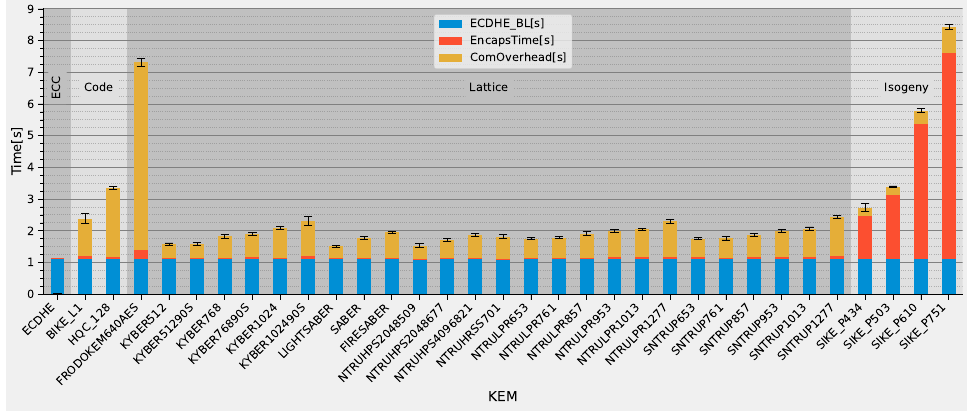
Figure 7. TLS 1.2 handshake latency for all NIST Round 3 KEMs with 20 ms BLE connection